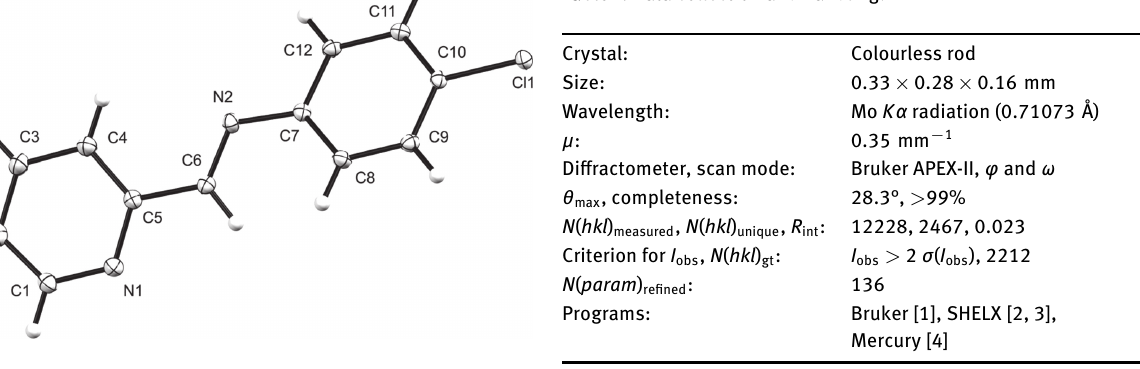
Table 1: Data collection and handling.